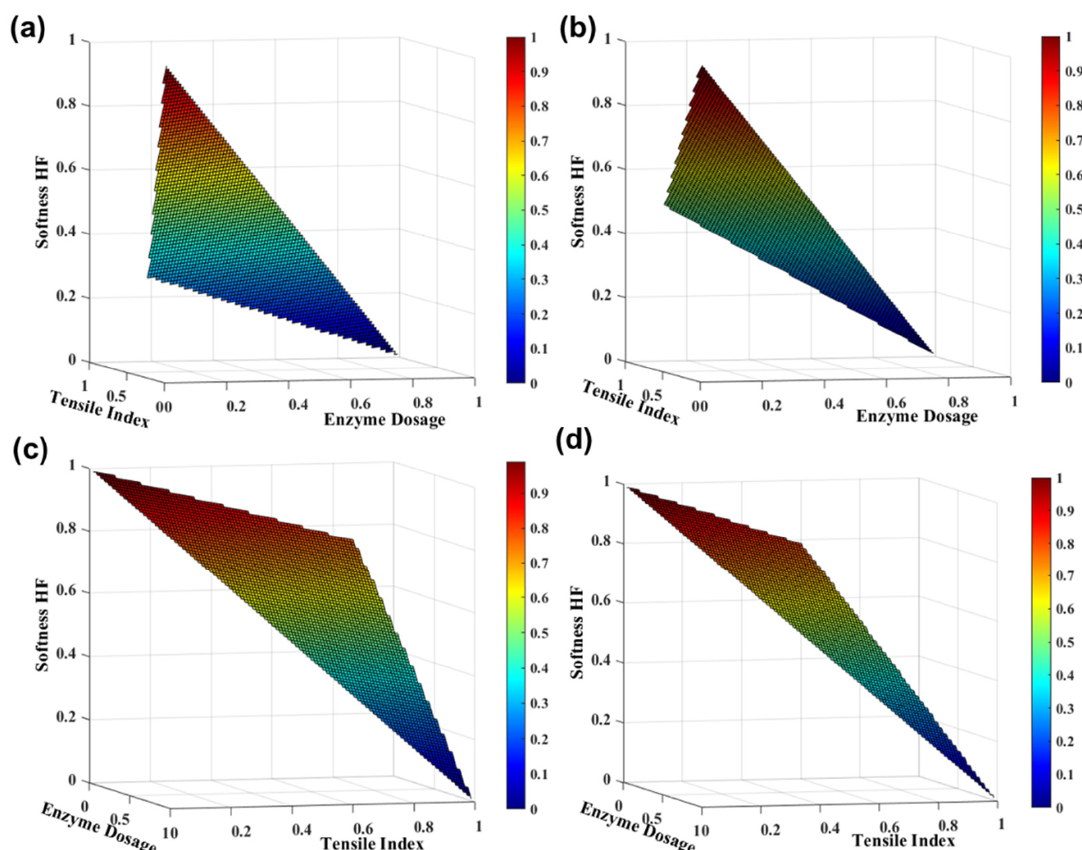
Figure 4. TSA softness HF and tensile index properties with enzyme dosages in eucalyptus kraft pulp ( a , b ) and eucalyptus sulfite pulp ( c , d ) for 30 min ( a , c ) and 60 min ( b , d ). The variables were normalized.